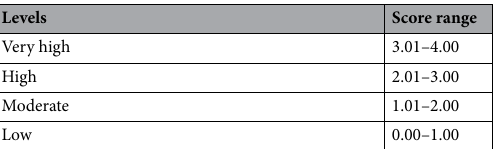
Table 2. The levels defined based on the ranges of the index scores for climate stressors, sensitivity, adaptive capacity and cumulative vulnerability 66,72 .